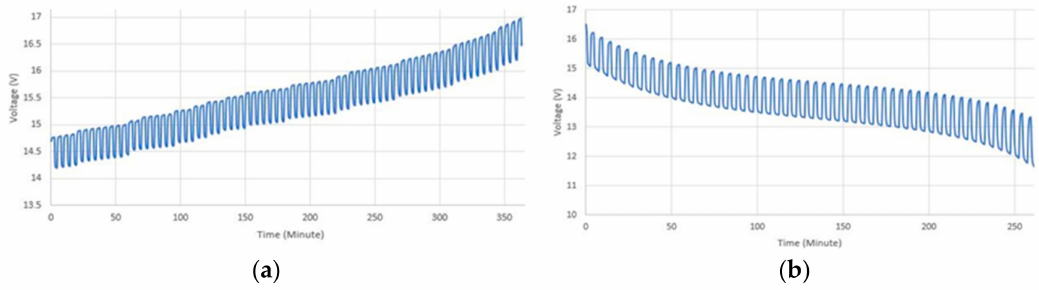
Figure 13. Voltage curves of the 80 Ah SLI battery pack during pulse charging and discharging simulations: ( a ) Charging; ( b )